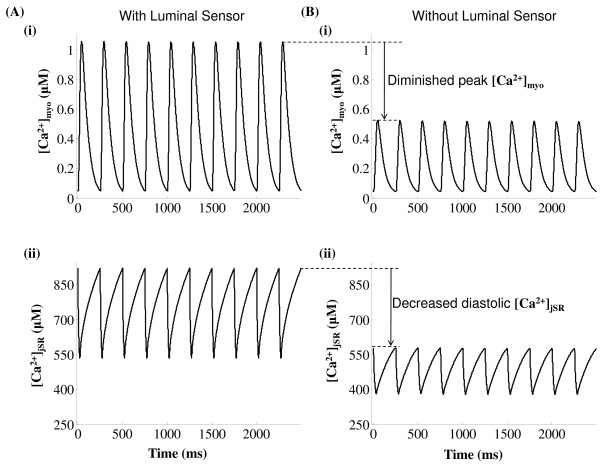
Role of Luminal sensor. Figure 14: Application of a train of voltage clamp pulses (amplitude -40 to 10 mV; duration 50 ms) for a period of 2.5 sec. Pulse repetition rate is 4.0 Hz. Luminal sensor is intact in A and removed in B. Both A and B are steady state responses to voltage clamp stimulation. A-(i) [Ca2+]myo transients with normal amplitude. A-(ii) Sustained SR filling due to robust RyR inactivation. B-(i) Diminishing [Ca2+]myo transients indicate poor SR filling. B-(ii) Lowered [Ca2+]jSR levels indicating inadequate refilling of SR stores due to lack of RyR refractoriness.